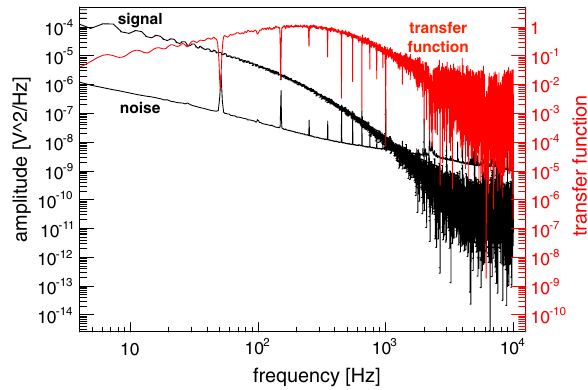
Fig. 3 Left axis: measured power spectra of randomly selected noise traces and of the template pulse (signal). Right axis: the corresponding filter transfer function. See text for details